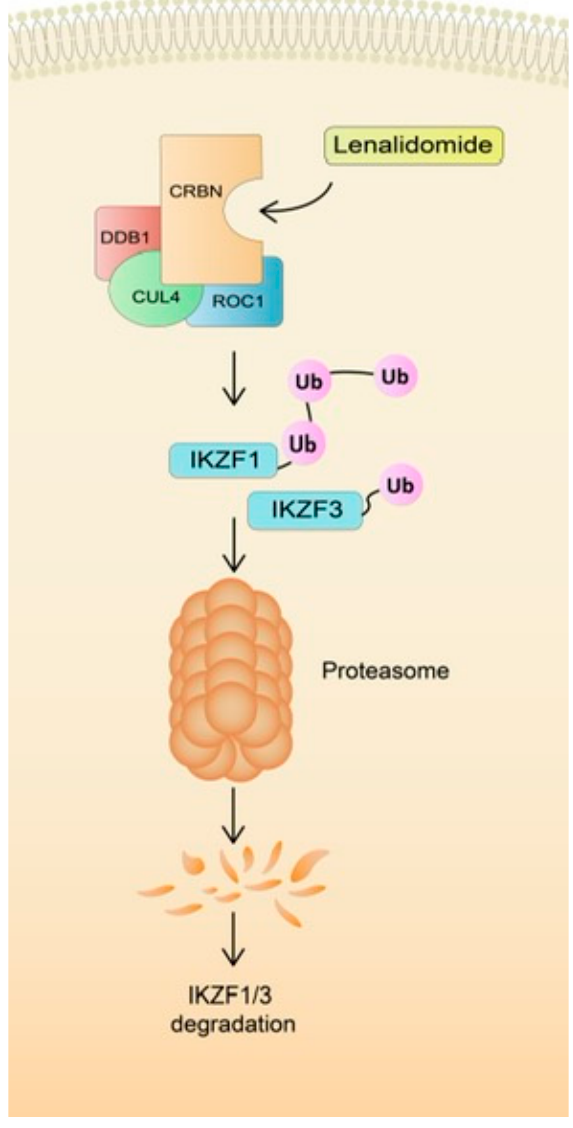
Figure 1. The mechanism of action of lenalidomide.